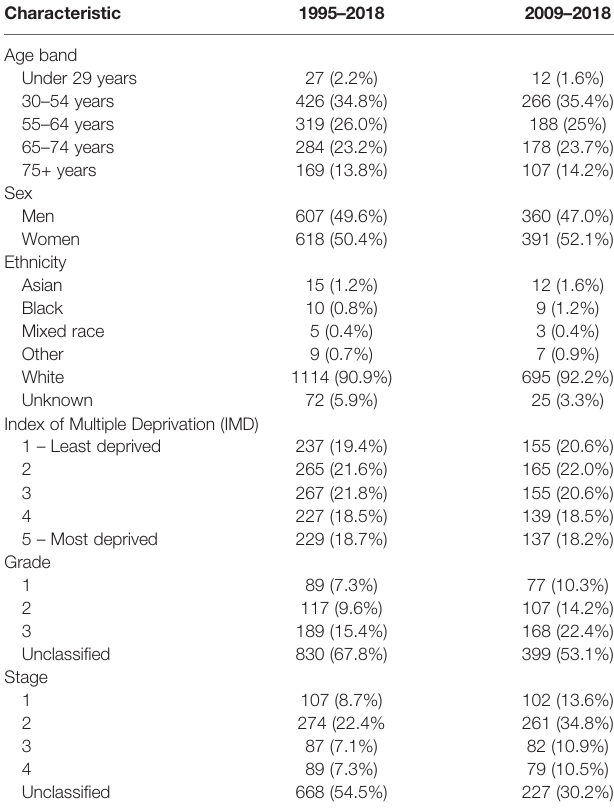
TABLE 1 | Demography and characteristics of the patient